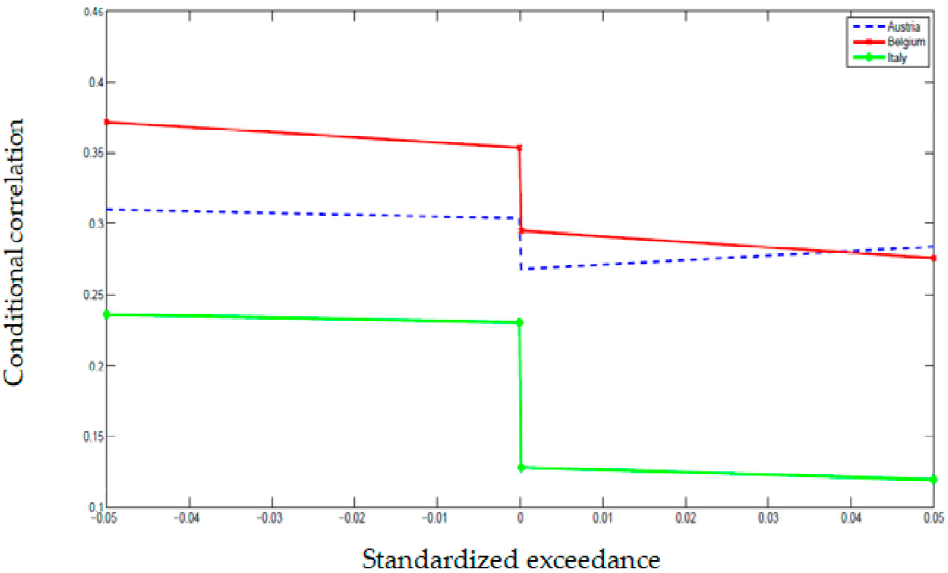
Figure 1. Asymmetric correlations.